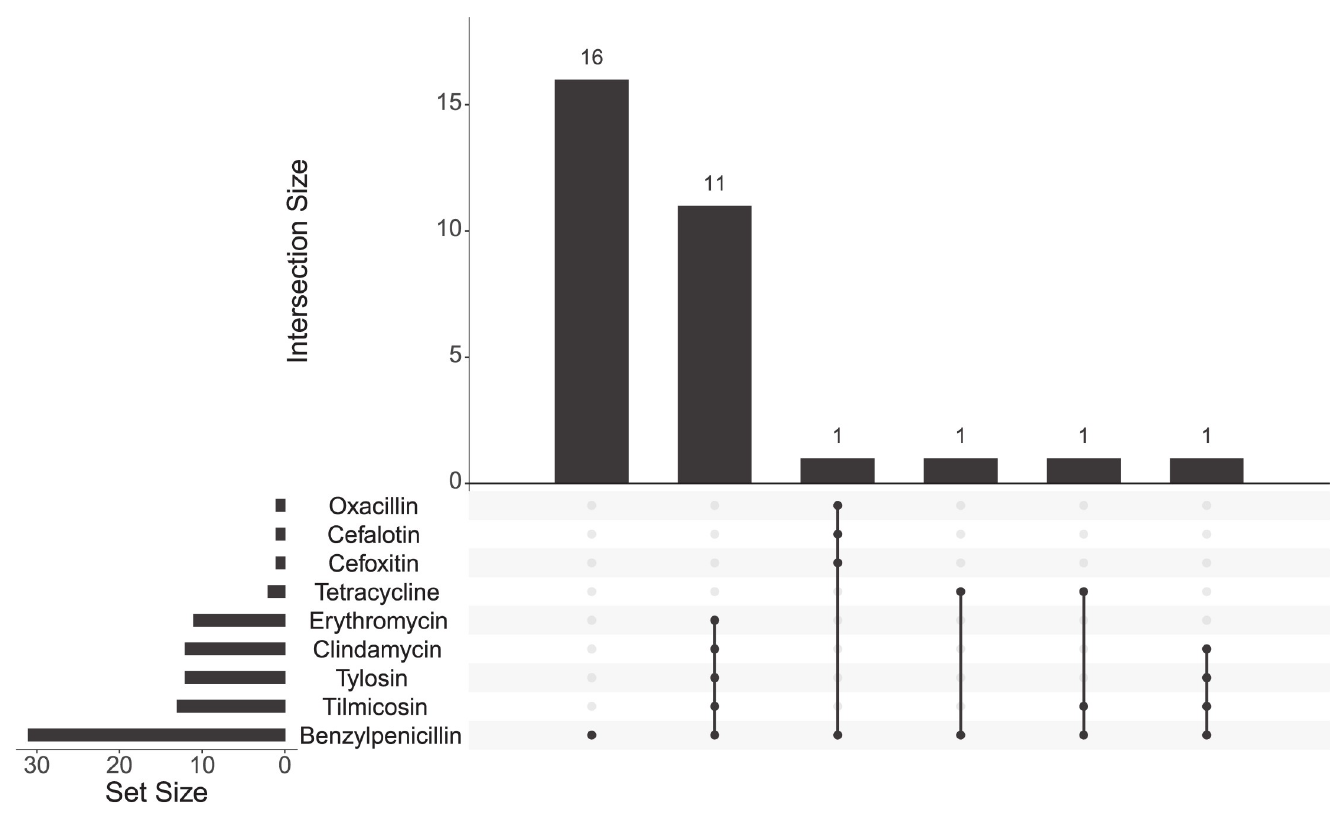
Fig 2. UpSet plot comparing the profiles of benzylpenicillin-resistant Staphylococcus aureus isolates. The total size of resistant S . aureus isolates is shown on the left bar plot. Antibiotic-resistant profiles of S . aureus isolates are visualized by the bottom plot and the occurrence is represented on the top bar plot.